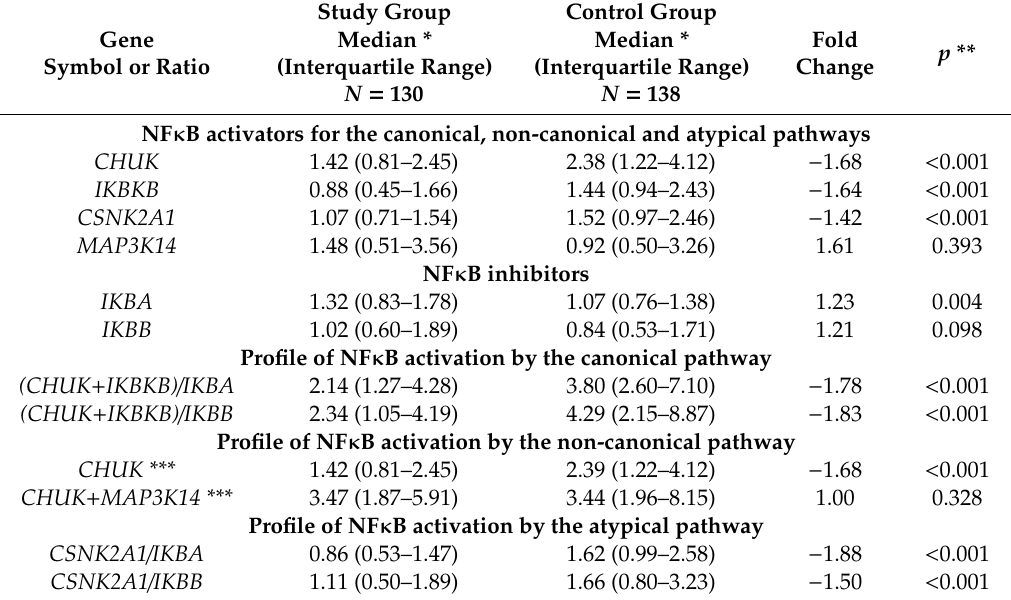
Table 2. Comparison of gene expression between the study and control